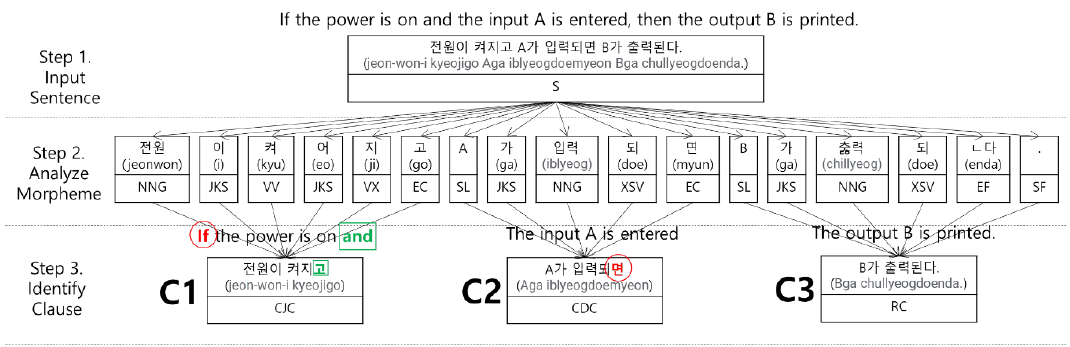
Figure 7. One example of identifying the priority of clauses in a simple sentence.